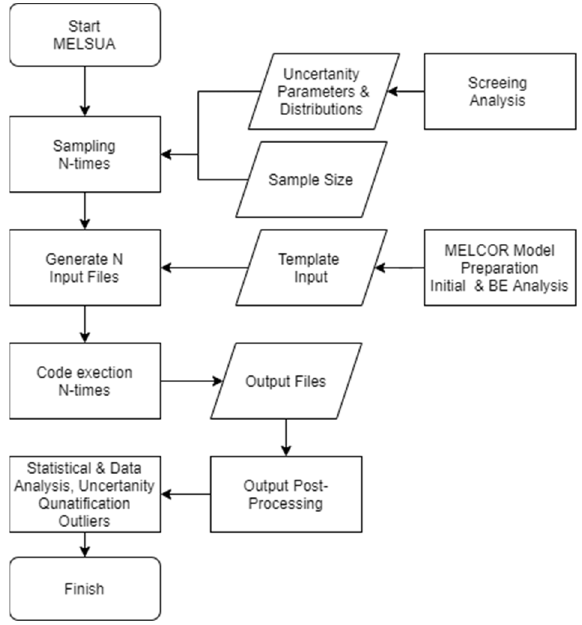
Figure 5. Workflow of the MelSUA code-based methodology.